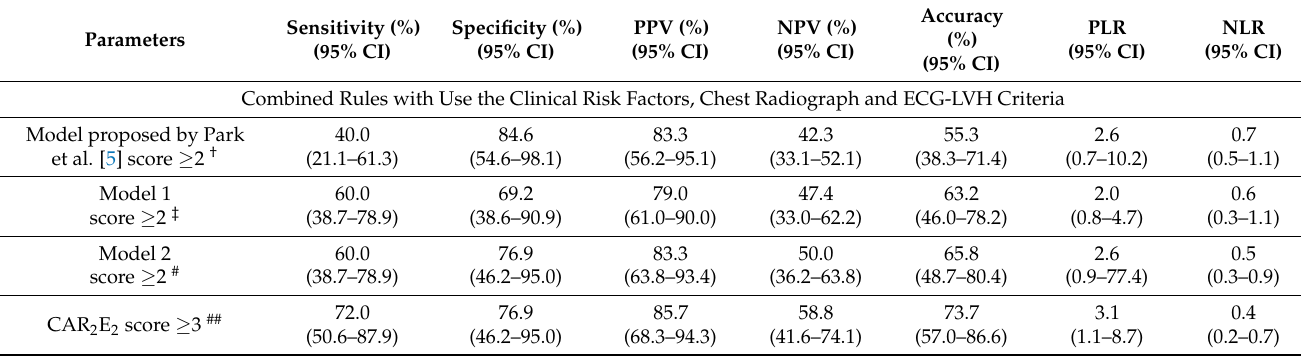
Table 6. Combined criteria for screening of left ventricular hypertrophy and their sensitivity, speci- ficity, positive predictive value, negative predictive value, accuracy, positive likelihood ratio and negative likelihood ratio. Data are shown for indexed left ventricular mass by body surface